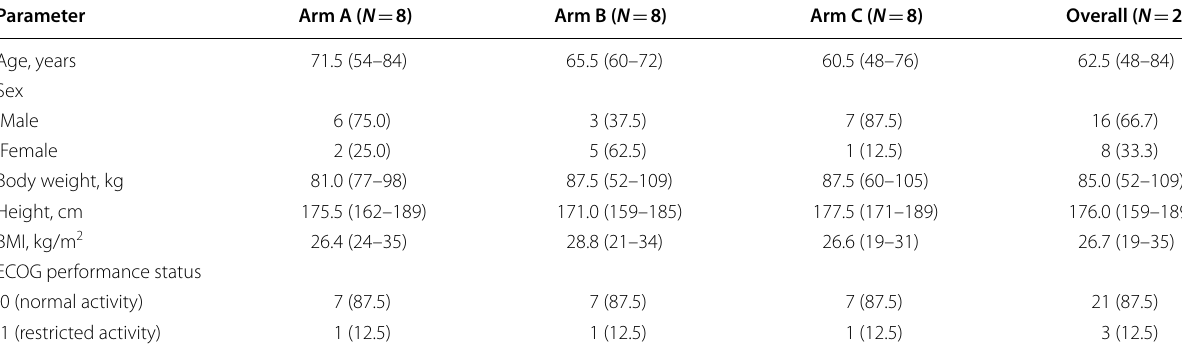
Data are presented as n (%) or median (range). Percentages are calculated as n/N BMI body mass index, ECOG Eastern Cooperative Oncology Group